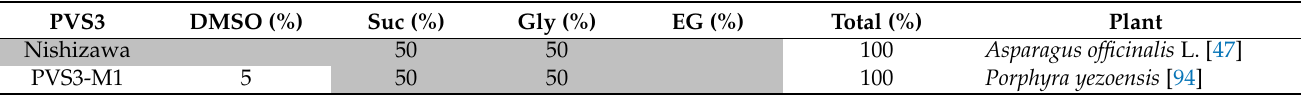
Table 4. The concentration of substances of the original Plant Vitrification Solution 3 (PVS3) [47]. Important composition changes added or omitted substances, and/or modification in the concentrations of original PVS3 in % ( w / v ) used in plant